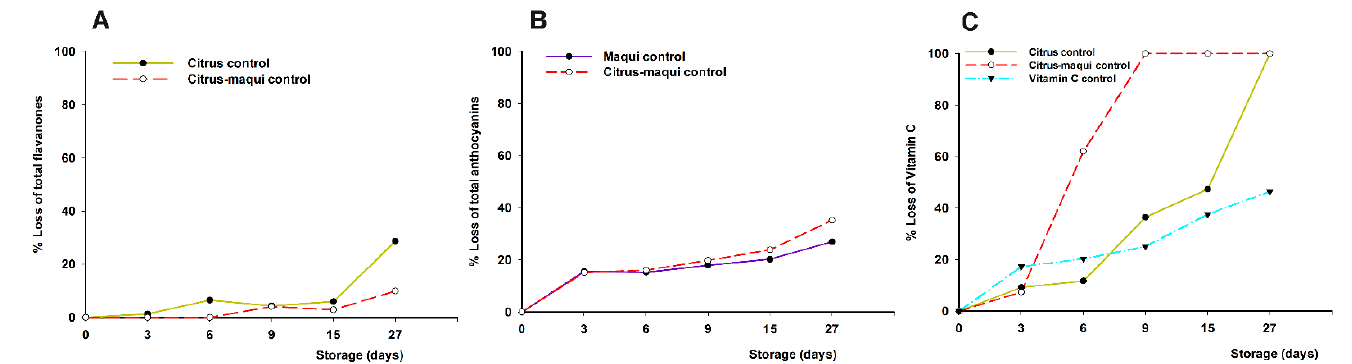
than the citrus–maqui control)).